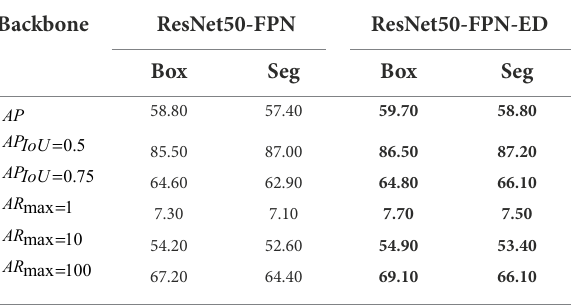
TABLE 6 Performance comparison between the improved Mask R-CNN backbone and the original one on the Grape-B test set. Backbone